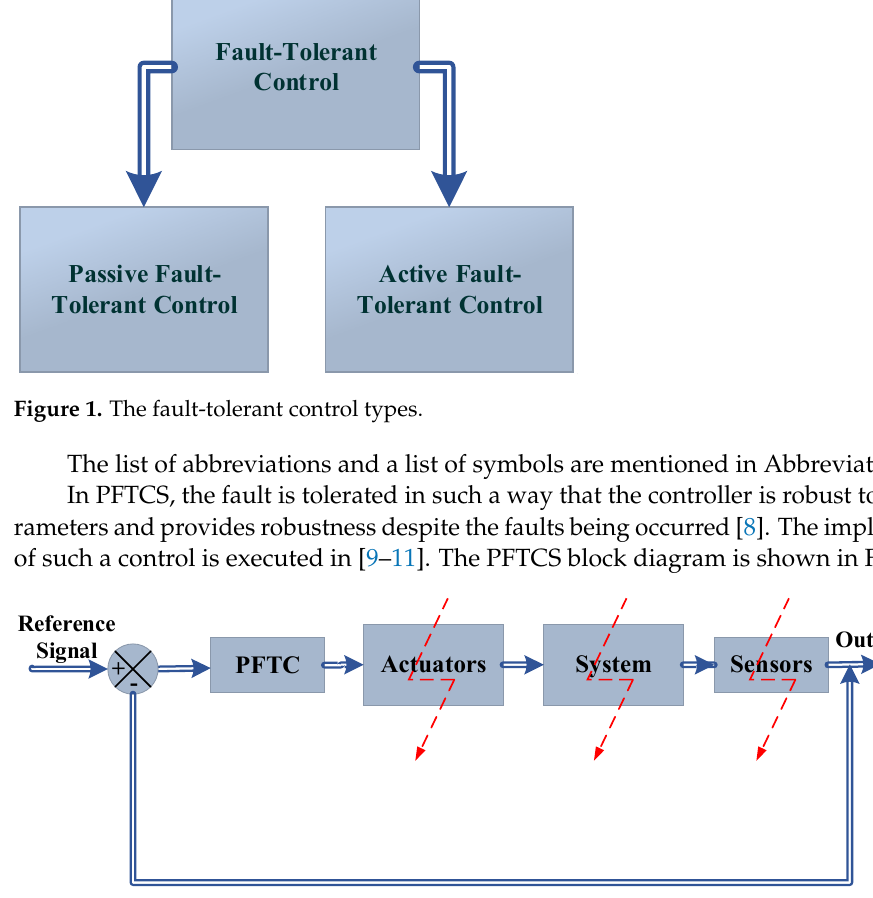
Figure 2. The passive fault-tolerant control [1].